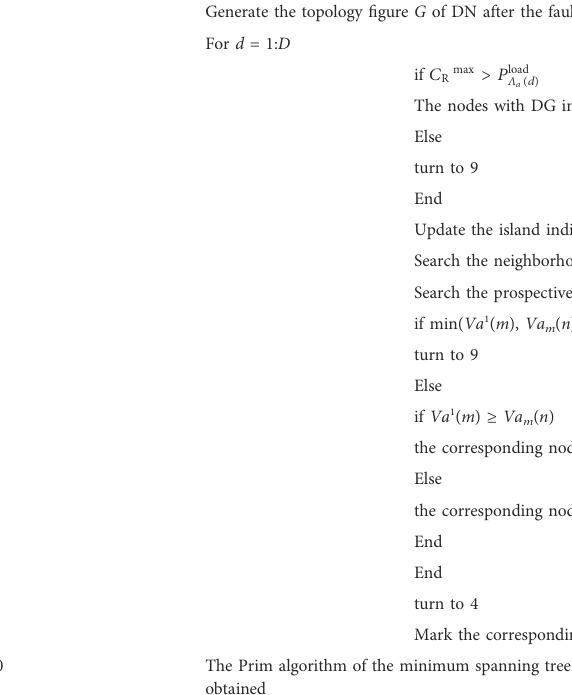
Step 6: The compressed node s a is restored to the original form of fi gure G . Judge whether the DN is with a ring network and Prim algorithm of the minimum spanning tree is applied to disconnect the ring network, and the MIP scheme with a radial structure is obtained.